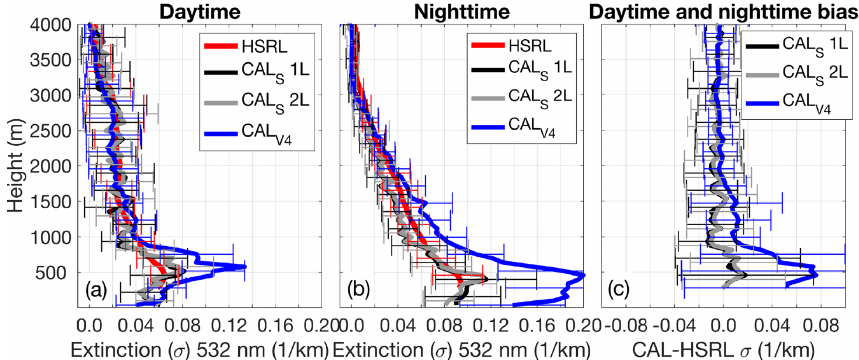
Figure 3. Mean aerosol extinction coefficient profile from the HSRL (red), CALIPSO–SODA 1L (black), 2L (gray) and the CALIPSO standard V4 product (blue) during (a) daytime and (b) nighttime. (c) Total mean bias of CALIPSO-based extinction relative to the HSRL: CALIPSO–SODA 1L (black) and 2L (gray); CALIPSO V4 (blue). Error bars in Fig. 3a and b denote 1 standard deviation, and RMSE is shown in Fig. 3c. Table 3. As in Table 1 but for V4 and SODA aerosol extinction coefficient in the lower troposphere (below 3.0km). CALIOP-based